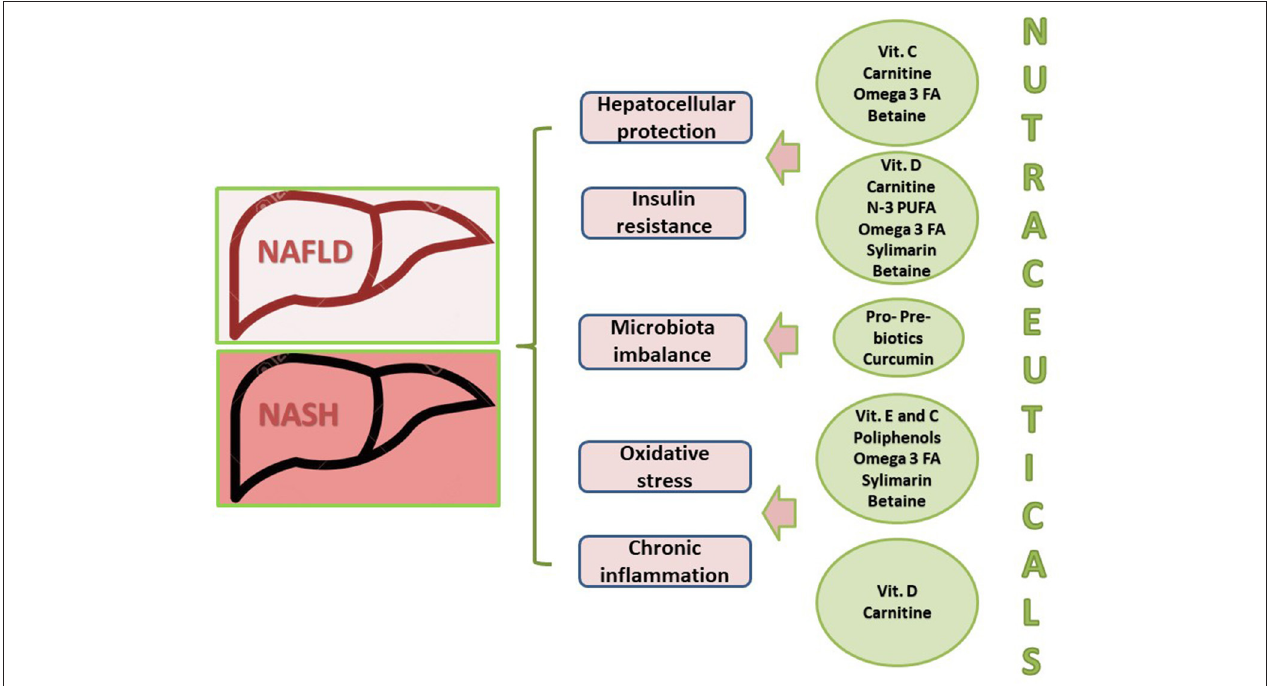
FIGURE 3 | Multiple targets of nutraceuticals for the treatment of non-alcoholic fatty liver disease. FA, fatty acids; NAFLD, non-alcoholic fatty liver disease; NASH, non-alcoholic steatohepatitis. Adapted and modified by Del Ben et al. (103).